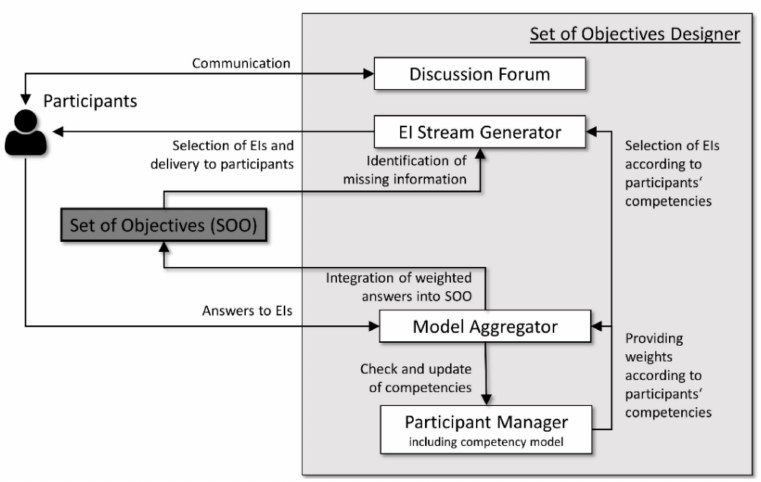
Figure 4. Set of Objectives Designer: Components and